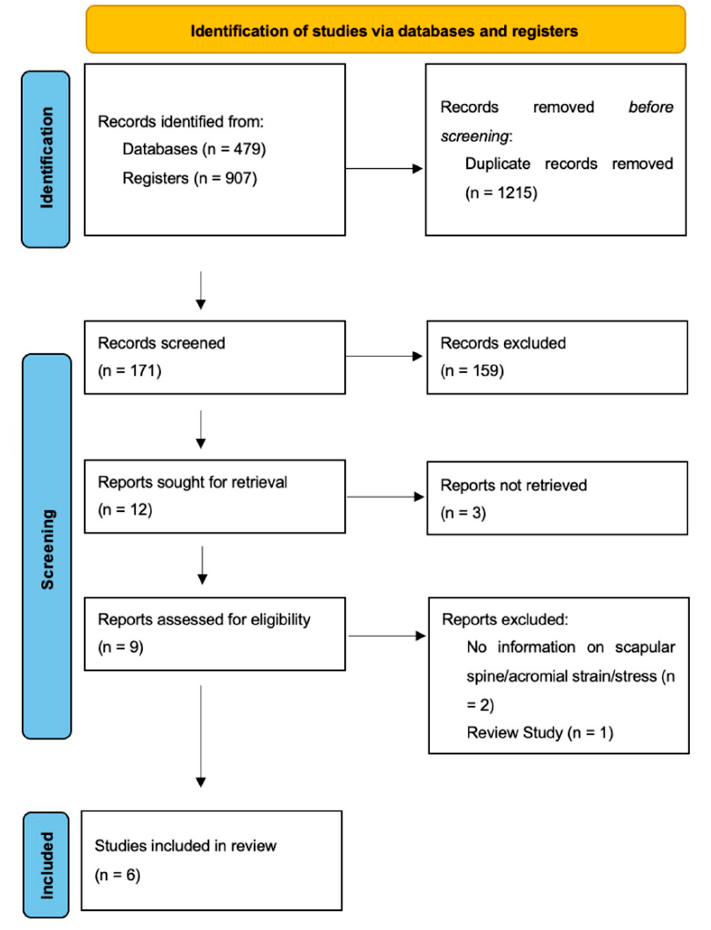
Figure 2. PRISMA flow diagram of the systematic search.